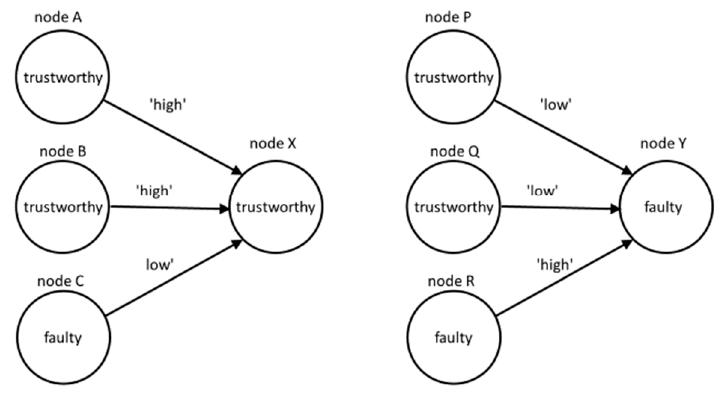
Figure 2. Example of two types of node configurations in the UOG.